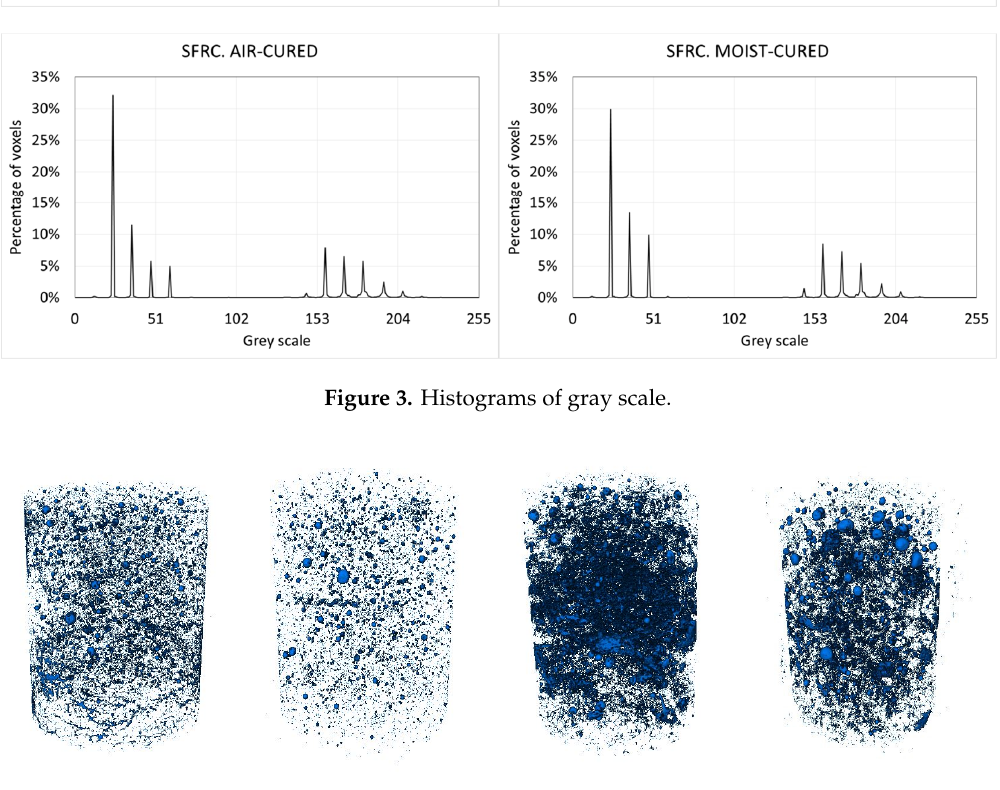
Figure 3. Histograms of gray scale.